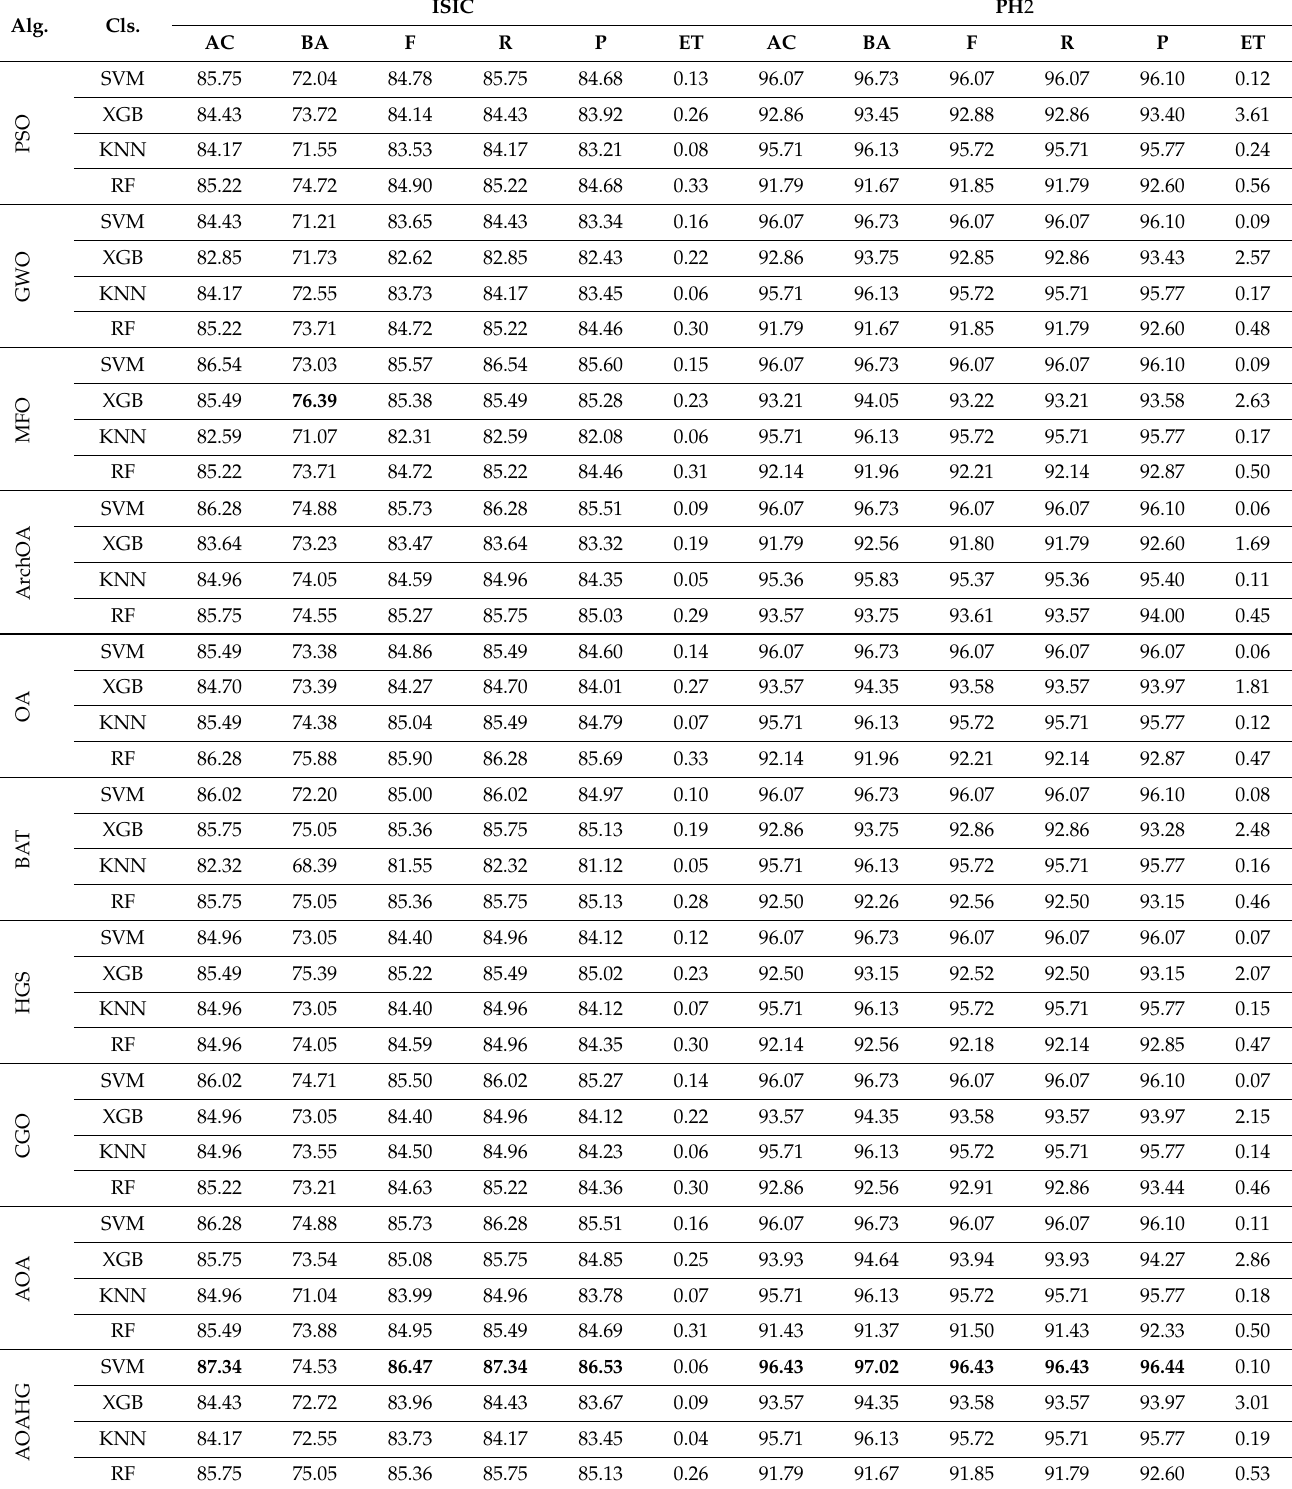
Table 2. Classification results (%) of each FS algorithm using two skin datasets (ISIC and PH2). ET is the execution